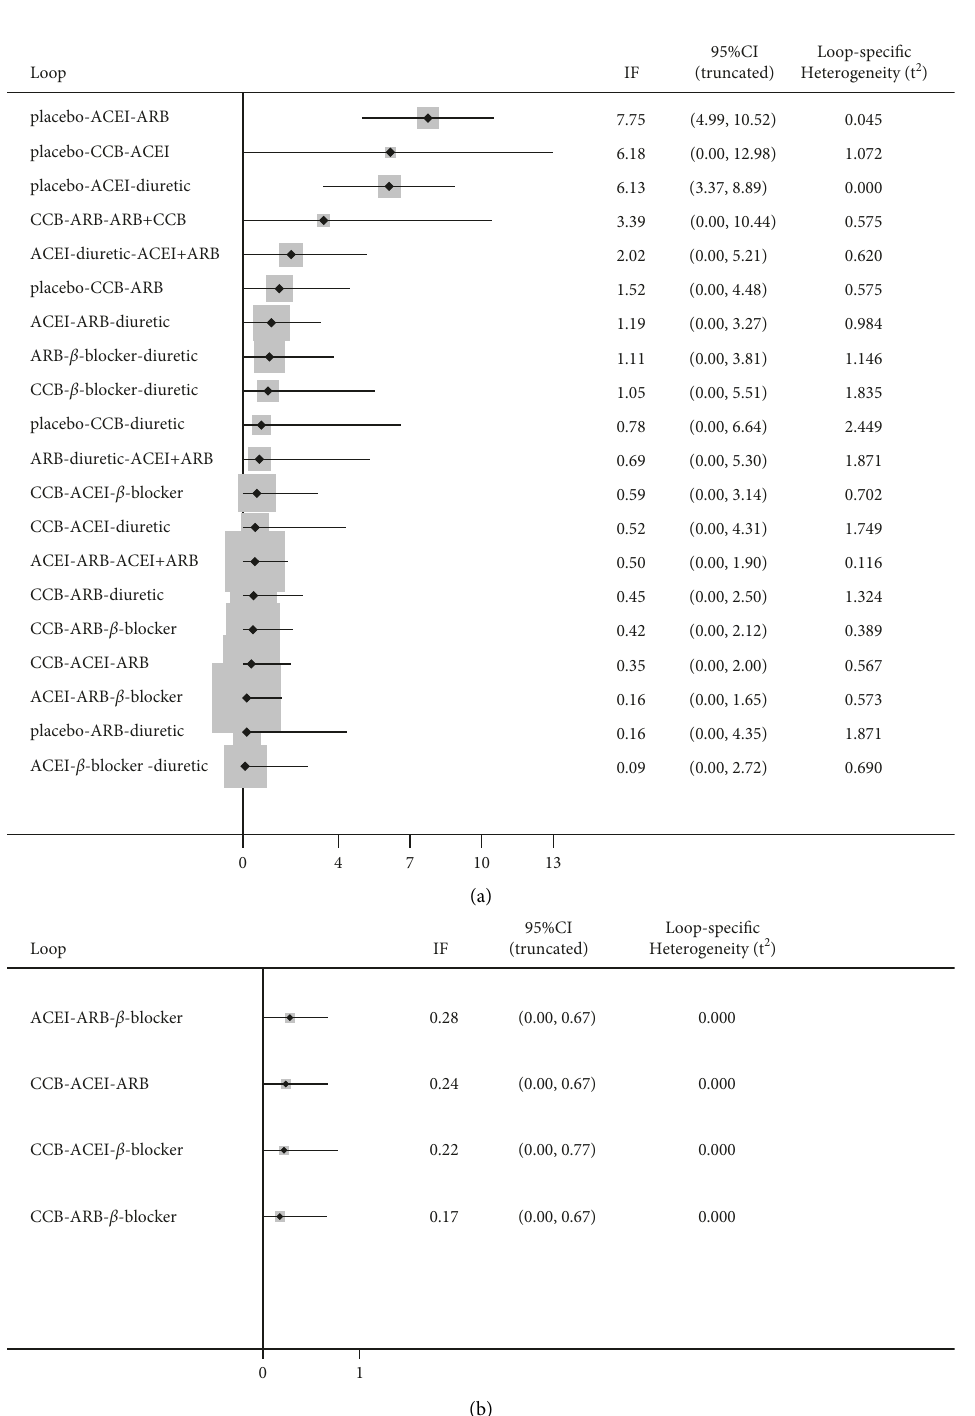
Figure 6: Results of test for inconsistency. (a) Flow-mediated dilation, (b) brachial artery diameter) ACEI: angiotensin-converting enzyme inhibitors, ARB: angiotensin receptor blocker, CCB: calcium channel